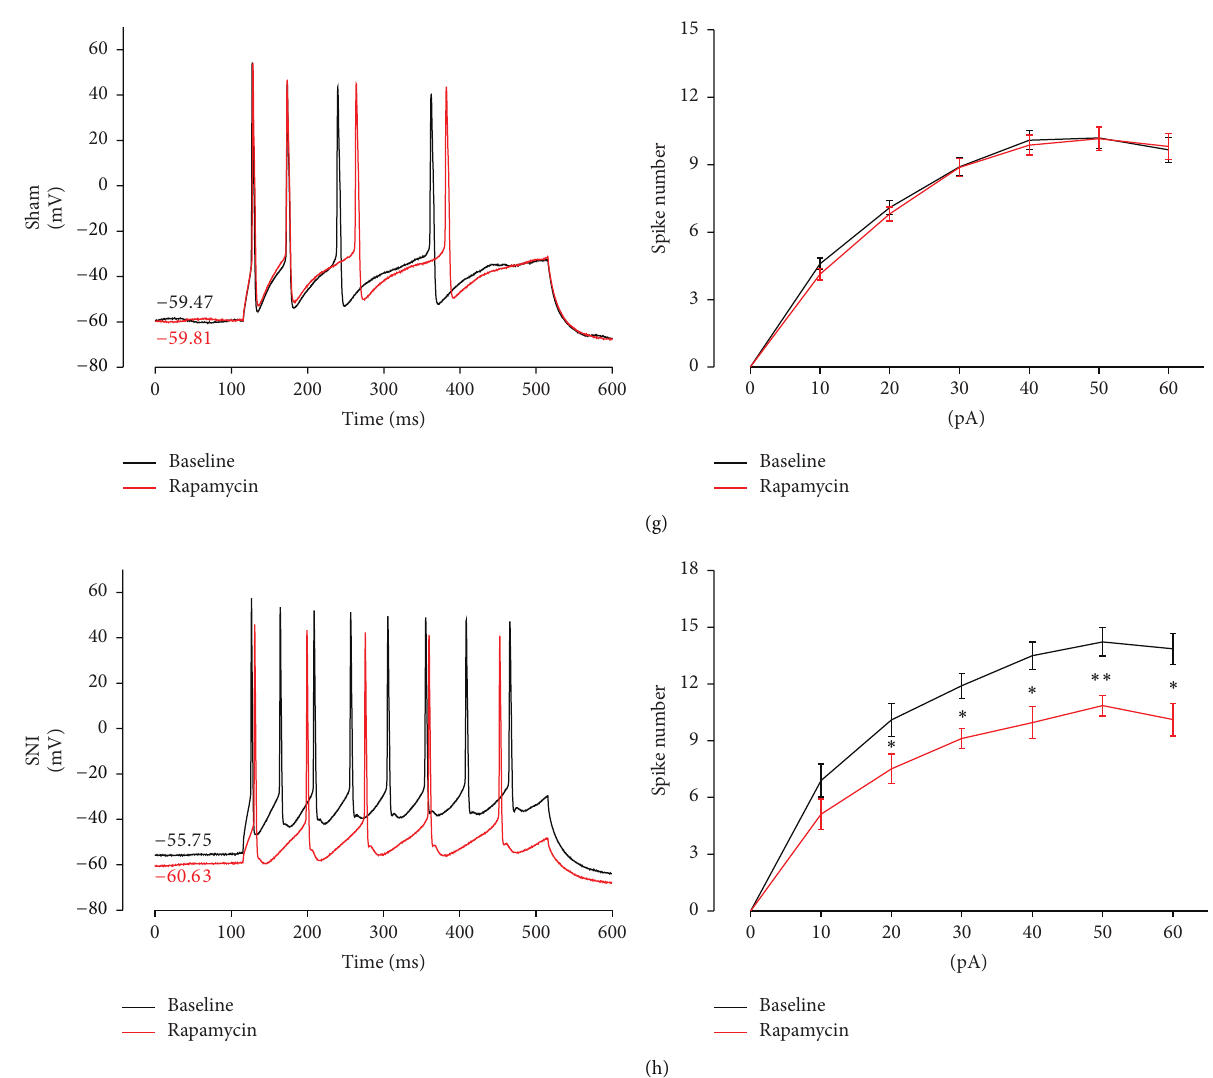
Figure 5: The neuronal excitability of 5-HTergic neurons in the RVM was significantly increased in SNI rats, which could be effectively impaired by rapamycin via a postsynaptic mechanism. (a) In vitro brain slice infusion revealed that rapamycin (250 𝜇 M) rapidly inhibited the activation of mTOR in SNI rats. Consistently, in the absence of rapamycin, SNI produced a significant increase in the levels of phosphorylated mTORandS6K( ∗ 𝑃 < 0.05 comparedtothesham+vehiclegroup, 𝑛 = 4 ).Aftertreatmentwithrapamycin(250 𝜇 M)onday7,theupregulation of p-mTOR and p-S6K levels was remarkably decreased ( # 𝑃 < 0.05 compared to the SNI + vehicle group, 𝑛 = 4 ) in brain slices from SNI rats. (b) One representative whole-cell patched neuron in the RVM was injected with biocytin (labeled with Alexa 594, red). This cell also showed 5-HT immunoreactivity (Alexa 488, green). The same neuron is also pictured during whole-cell patching (RMg: raphe magnus nucleus; RPa: raphe pallidus nucleus). Scale bars = 100 𝜇 m (above) and 25 𝜇 m (below). (c)–(e) Superimposed samples and cumulative fraction results showing that rapamycin inhibited the amplitude rather than the frequency of spontaneous excitatory postsynaptic currents (sEPSCs) in the RVM 5-HTergic neurons. (c), (e) Bath application of rapamycin (250 𝜇 M) had no effect on the frequency and amplitude of the sEPSCs in rats with sham surgery. (d), (e) Rapamycin (250 𝜇 M) inhibited the frequency but not the amplitude of sEPSCs in rats with SNI. (f) Summarized results for the effects of rapamycin on sEPSCs in rats with SNI or sham surgery ( ∗ SNI versus sham 𝑃 < 0.05 , 𝑛 = 15 ; # SNI + rapamycin versus sham + rapamycin, 𝑃 < 0.05 , 𝑛 = 15 ). (g) Sample traces and average results showing that the number of action potentials (APs) in a train induced by the injection of step currents (400 ms, 0–60 pA) was not affected by rapamycin in the sham group ( 𝑛 = 15 , 𝑃 > 0.05 , two-way repeated measures ANOVA). (h) Sample traces and average results showing that the number of APs in a train induced by the injection of step currents (400 ms, 0–60 pA) was significantly reduced by rapamycin in the SNI group ( 𝑛 = 15 , 𝑃 < 0.05 , two-way repeated measures ANOVA). The Holm-Sidak post hoc test indicated that rapamycin decreased the spike number when currents of 20 ( 𝑡 = 2.50 , ∗ 𝑃 < 0.05 ), 30 ( 𝑡 = 2.62 , ∗ 𝑃 < 0.05 ), 40 ( 𝑡 = 2.34 , ∗ 𝑃 < 0.05 ), 50 ( 𝑡 = 3.34 , ∗∗ 𝑃 < 0.01 ), and 60 pA ( 𝑡 = 2.57 , ∗ 𝑃 < 0.05 ) were applied. It is worth noting that the resting membrane potential (RMP) was slightly hyperpolarized and that the amplitude of spikes was also slightly decreased in the SNI